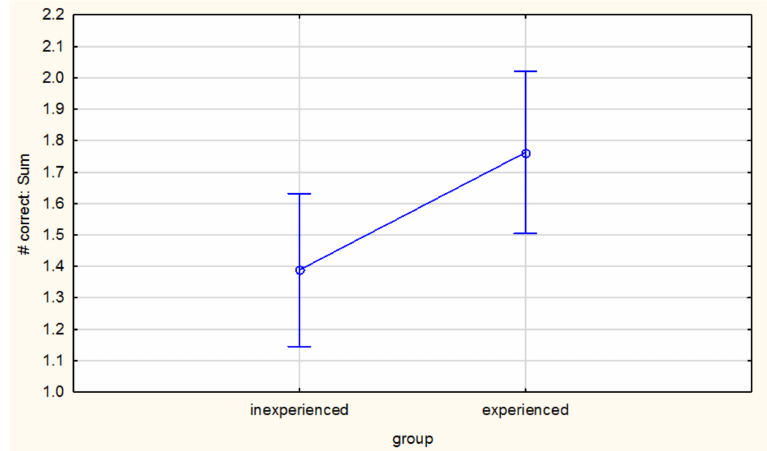
Figure 3. Group effect (Least Squares Means) of experienced vs inexperienced judges (Vertical bars denote 0.95 confidence